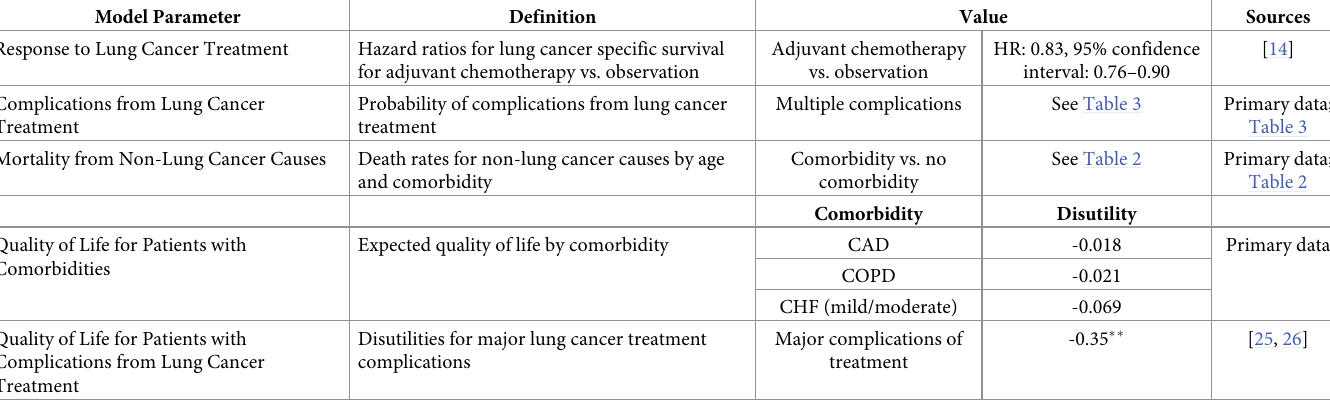
Table 1. Key input parameters for developing a microsimulation model of patients with non-small cell lung cancer. Model